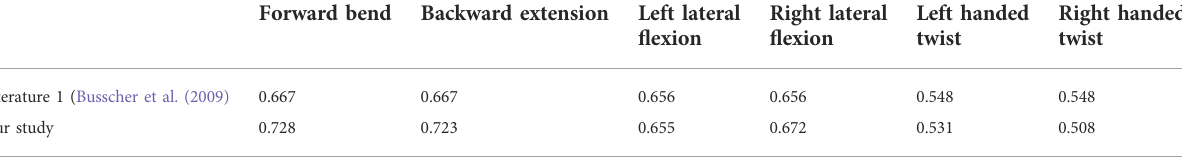
TABLE 3 The average stiffness values of T1 – T4 segments under the six motion